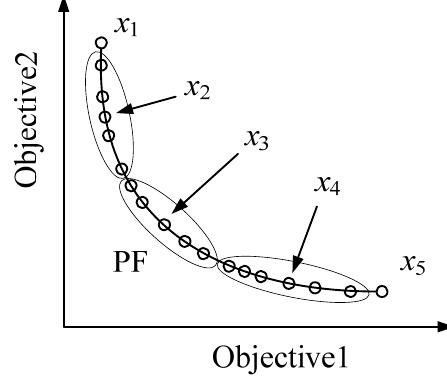
Figure 2. The Pareto optimal Front (PF) of multi ‐ objective problem.